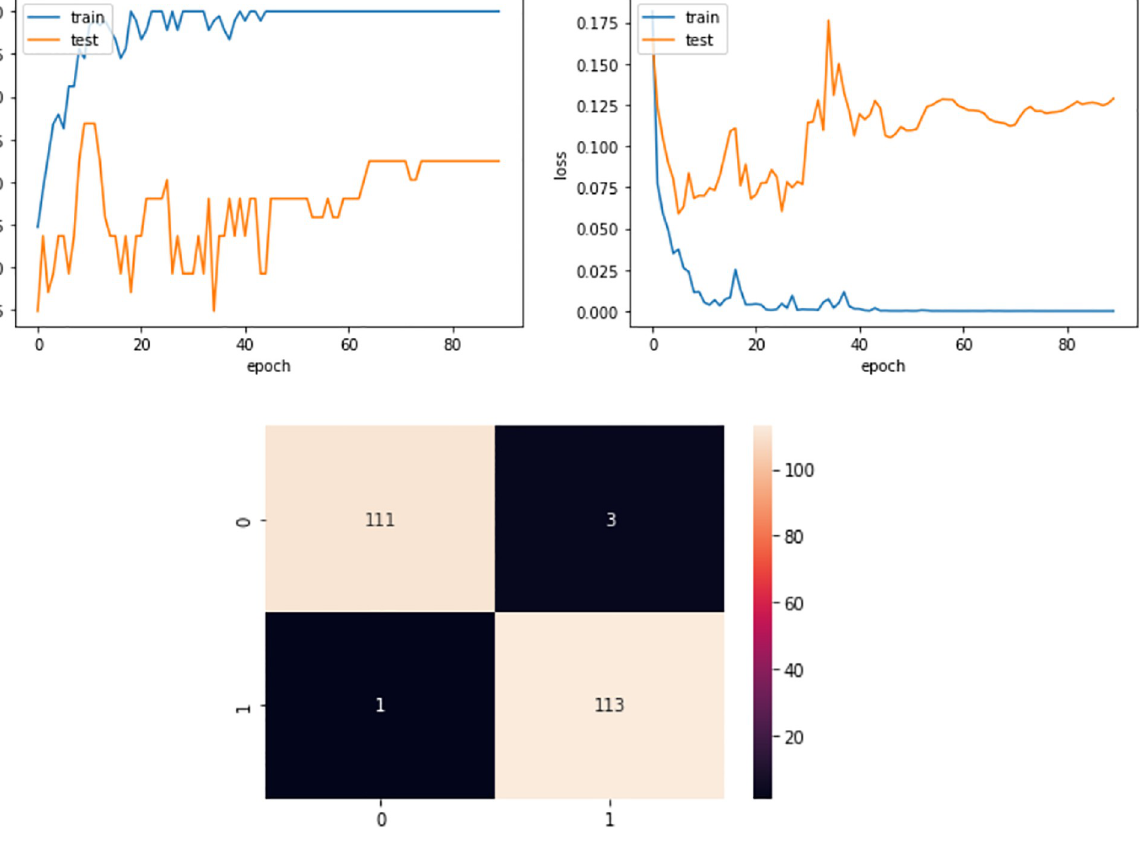
Fig 4. Accuracy curve, loss curve, and confusion